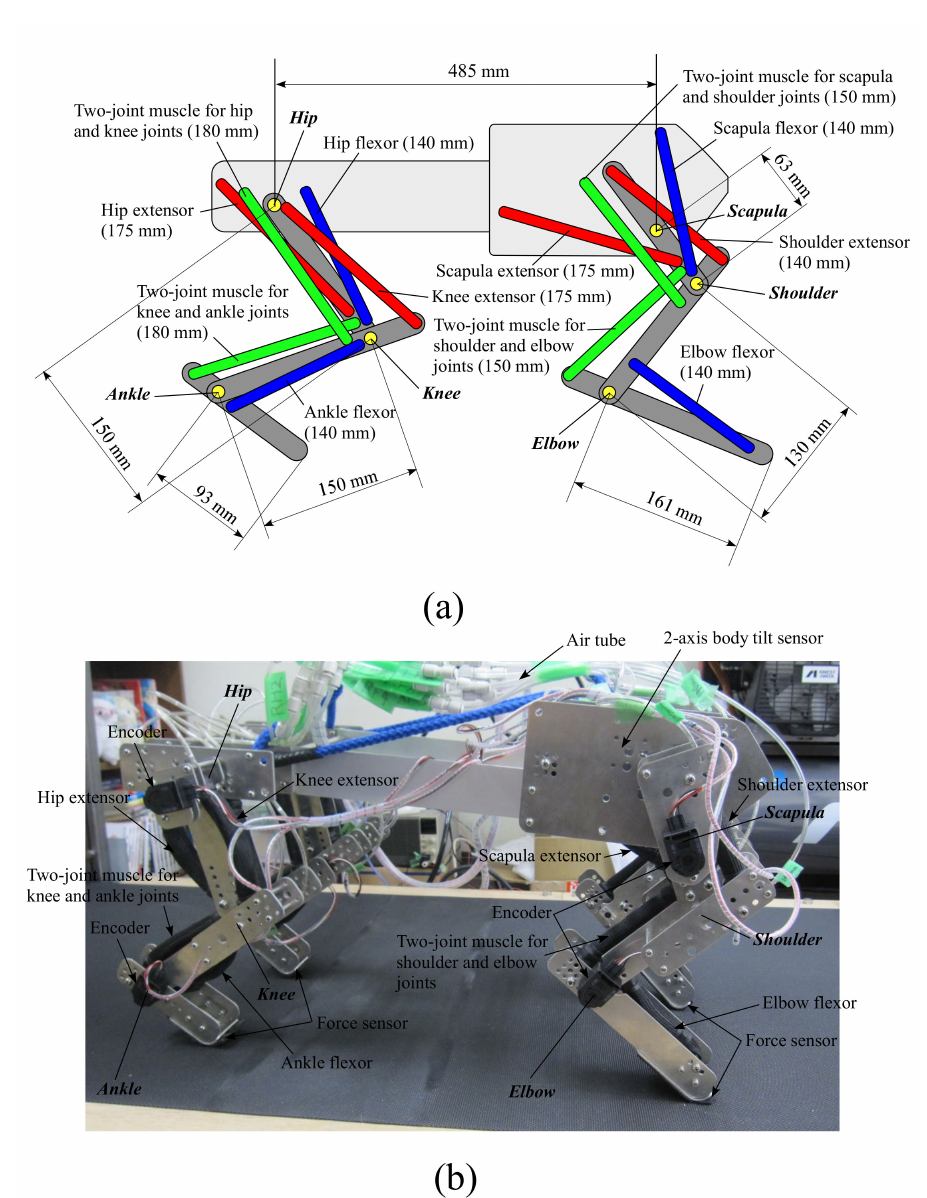
Figure 3. Configurations of the fore and hind legs ( a ), and an image of our quadruped robot ( b